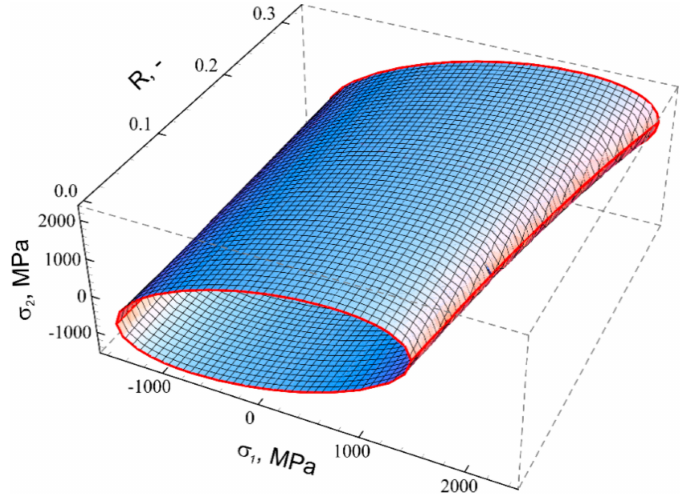
Figure 5. The safe area is inside the ellipsoid surface, σ 1 and σ 2 are shown as a function of the fatigue ratio, R; 0 ≤ R ≤